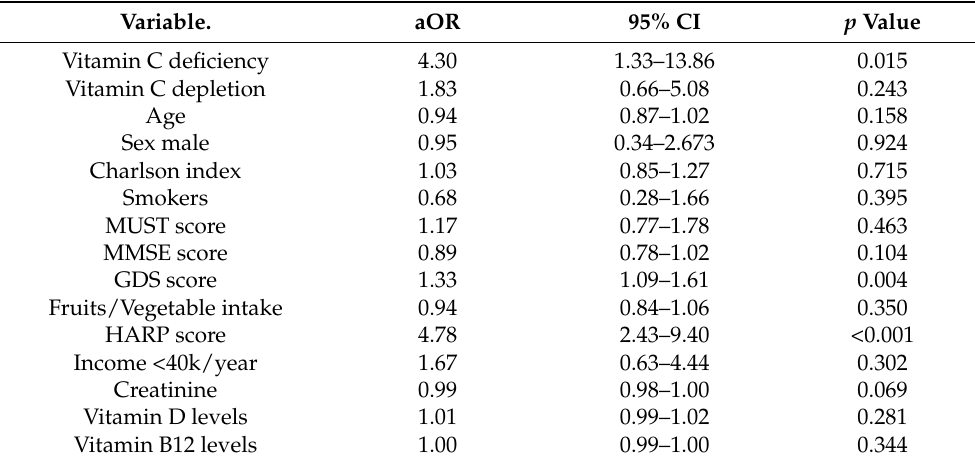
Table 2. Logistic regression model showing adjusted odds ratios in moderate–severely frail patients compared to non-frail/vulnerable/mildly frail patients with normal vitamin C status as the baseline. Variable. aOR 95% CI p Value Vitamin C deficiency